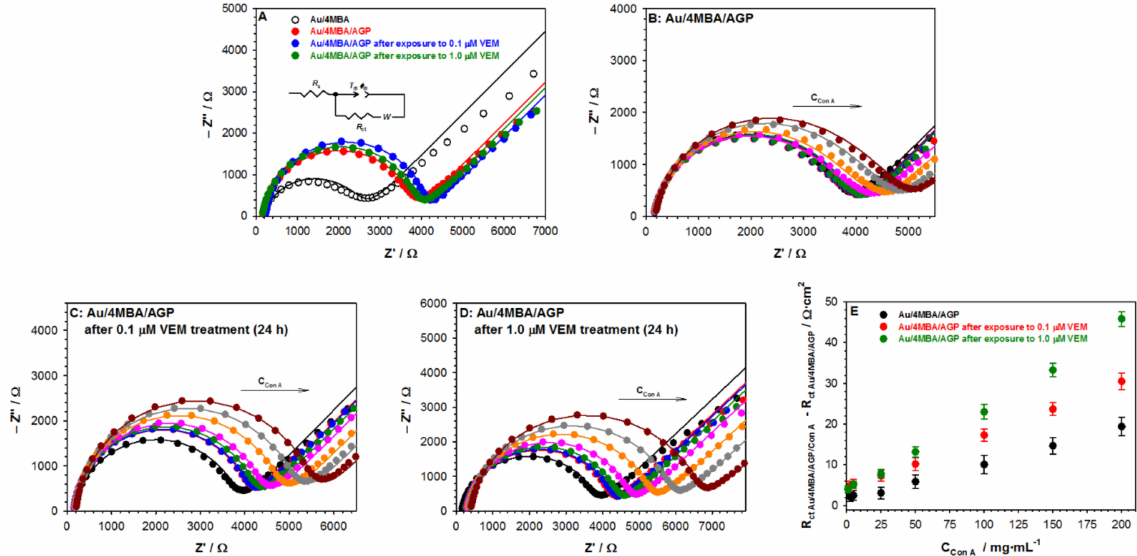
Figure 4. ( A ) Nyquist plots recorded during subsequent steps of electrode modification and before (white points) and ( B – D ) after (colored points) the interaction of Au/4MBA/GPA with ConA in various concentrations before and after VEM treatment; ( E ) Calibration plot based on EIS measurements obtained after the interaction between Con A and AGP without and with VEM treatment. Experimental conditions: PBST buffer with the addition of 1% DMSO; 5 mM Fe(CN) 6 3-/4- ; E app. = 242 mV, Au electrode ( φ = 1.6 mm). Solid lines are fitted to experimental data (points). Inset in graph A: Ershler– Randlaess equivalent circuit, where: R s –solution resistance, R ct –charge transfer resistance, φ dl and T dl are constant phase elements, W –Warburg